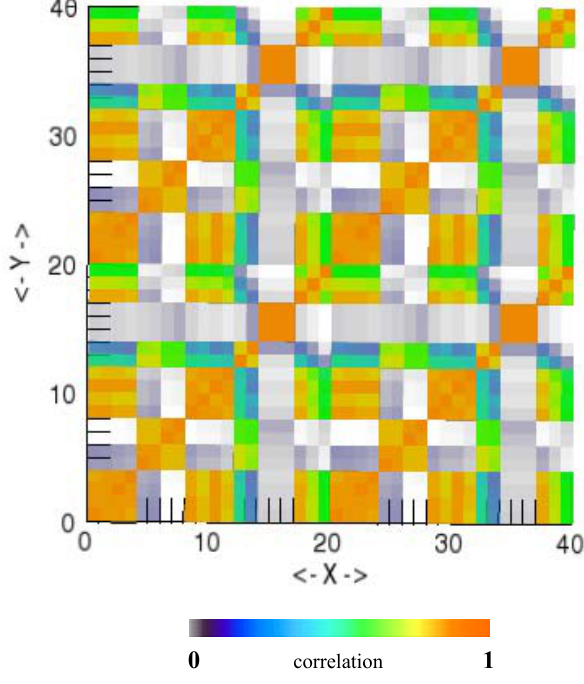
Fig 1. Graphical representation of the correlation between 40 predefined aerosol mixtures. Fig. 1. Graphical representation of the correlation between 40 pre- The maximum correlation elements are on the main diagonal of the matrix (self correlation). defined aerosol mixtures. The maximum correlation elements are There is also strong correlation between first and second halves of the 40 aerosol mixtures on the main diagonal of the matrix (self correlation). There is also because of similarity between these two subsets. Standard matrix normalization procedure strong correlation between first and second halves of the 40 aerosol (dividing by maximum element) was used. mixtures because of similarity between these two subsets. Stan- dard matrix normalization procedure (dividing by maximum ele- ment) was